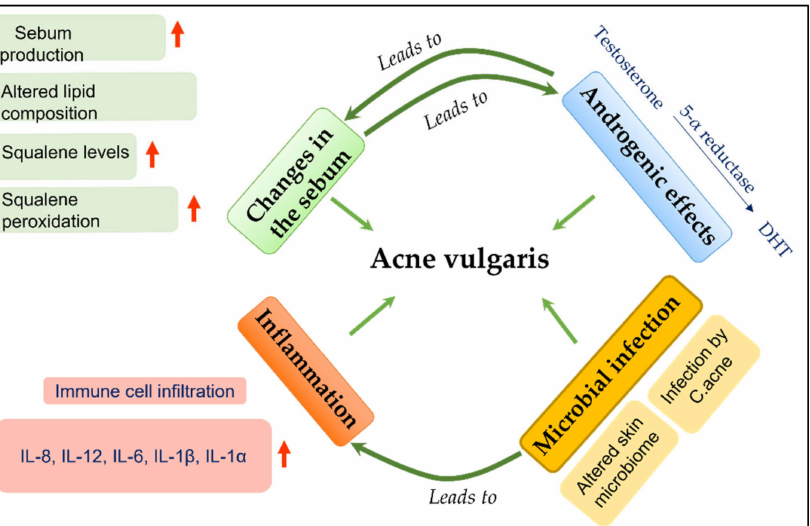
Figure 1. Key components of pathophysiology of acne vulgaris. Changes in the microbiome and infection by C. acne lead to the initiation of acne vulgaris. Although inflammation is beneficial for fighting against the infection, it can lead to aggravation of acne. In addition to this, androgenic factors can influence sebum quality and quantity and dihydrotestosterone (DHT). Changes in the sebum quality and quantity can create a conducive atmosphere for microbes during acne. Cell-based model systems to evaluate anti-acne ingredients take these components of pathology into consideration. The “up arrow” marked in red color indicates increase in